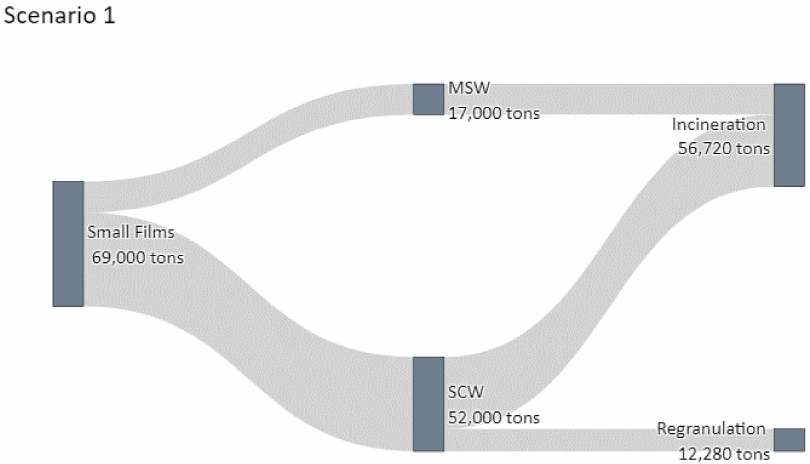
Figure 8. Sankey diagram depicting the waste flow in Scenario 1.